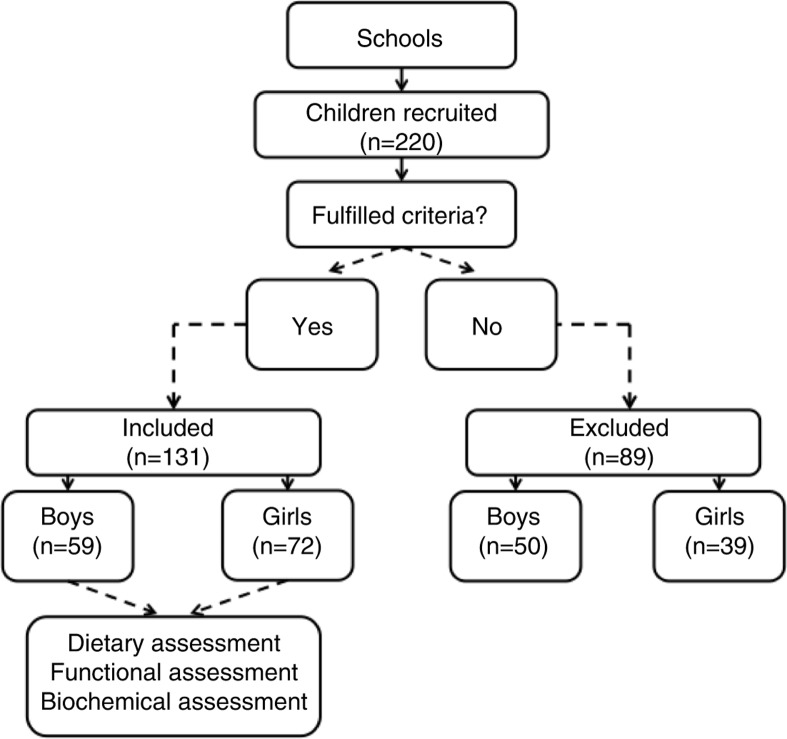
Design of the study group.